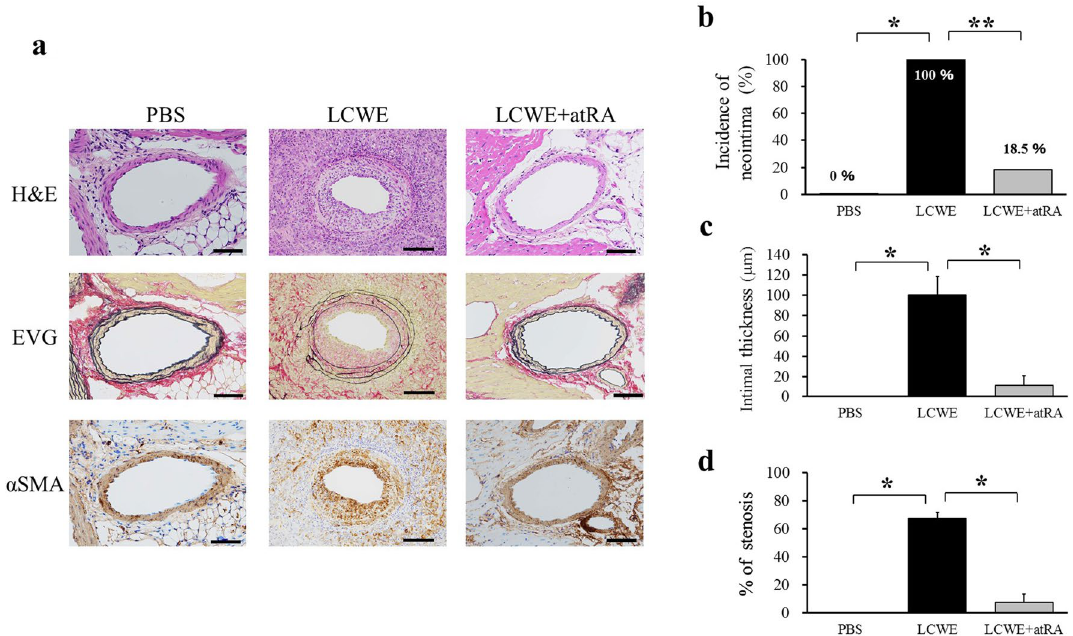
Figure 3. Effect of atRA on LCWE-induced CA stenosis. (a) H&E, EVG and α-smooth muscle actin (α-SMA) staining of CAs from mice treated with PBS (n = 5), LCWE (n = 6) and LCWE + atRA (n = 7) . Scale bar = 100 μm . The incidence of neointima (b) , intimal thickness (c) and % of stenosis (d) were compared among the groups. The data are expressed as the mean ± SD. *p < 0.01, **p < 0.05. All the data were generated from 1 experiment at the same